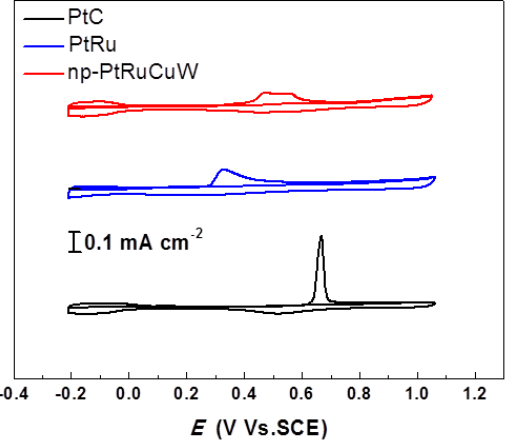
Figure 4. Electrochemical CO-stripping curves of the np-PtRuCuW, PtC and PtRu catalysts in the 0.5 M H 2 SO 4 solution (Scan rate: 20 mV s − 1